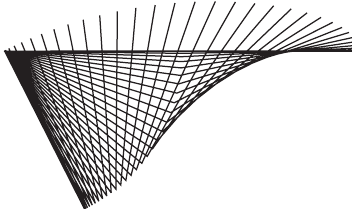
Figure 6: Sequence of configurations of the robot manipulator at times 𝑘/32 with 𝑘 = 0, 1,. .. ,32 corresponding to the optimal sol- ution of problem 3, an initial value problem for an underactuated 𝑅𝑅 planar robot manipulator with boundary conditions 𝜃 (𝑡 ) = 1 𝐼 0 [ rad ] , 𝜃 (𝑡 ) = 0 [ rad ] , ̇𝜃 (𝑡 ) = 0 [ rad / s ] , ̇𝜃 (𝑡 ) = 0[ rad / s ] , 2 𝐼 1 𝐼 2 𝐼 (𝑡 ) = free, 𝜃 (𝑡 ) = 𝜋[ rad ] , ̇𝜃 (𝑡 ) = 0[ rad / s ] , and ̇𝜃 𝜃 1 𝐹 2 𝐹 1 𝐹 2 (𝑡 ) = 0 [ rad / s ] , obtained with a discretization of [𝑡 , 𝑡 ] into 64 𝐹 𝐼 𝐹 subintervals. The initial and final times are 𝑡 𝐼 = 0 and 𝑡 𝐹 = 1 [ s ] , respectively. The corresponding control and state variables are represented in Figure